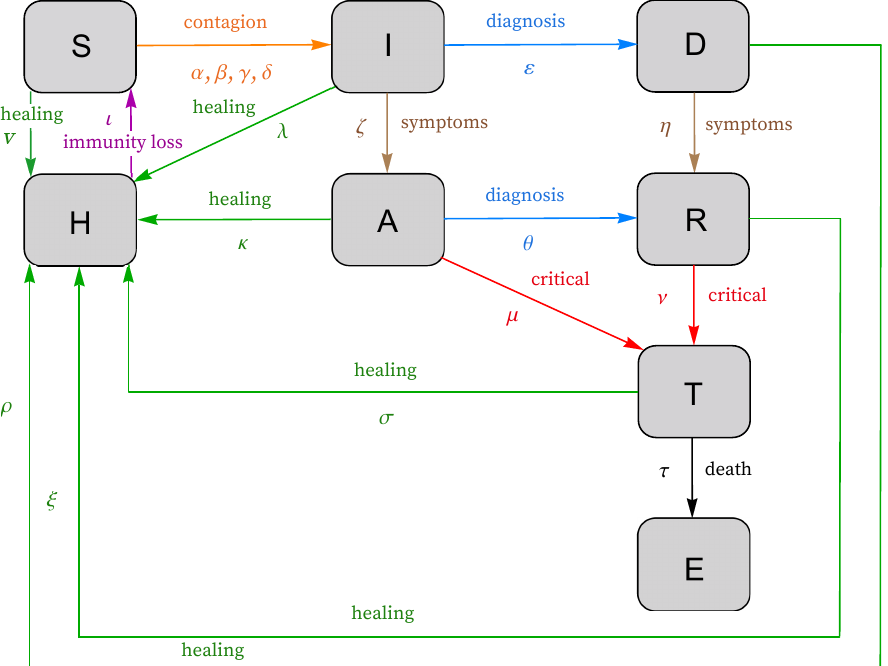
Figure 1. Schematic representation of the SIDARTHE compartmental model with vaccination and testing policies and immunity loss